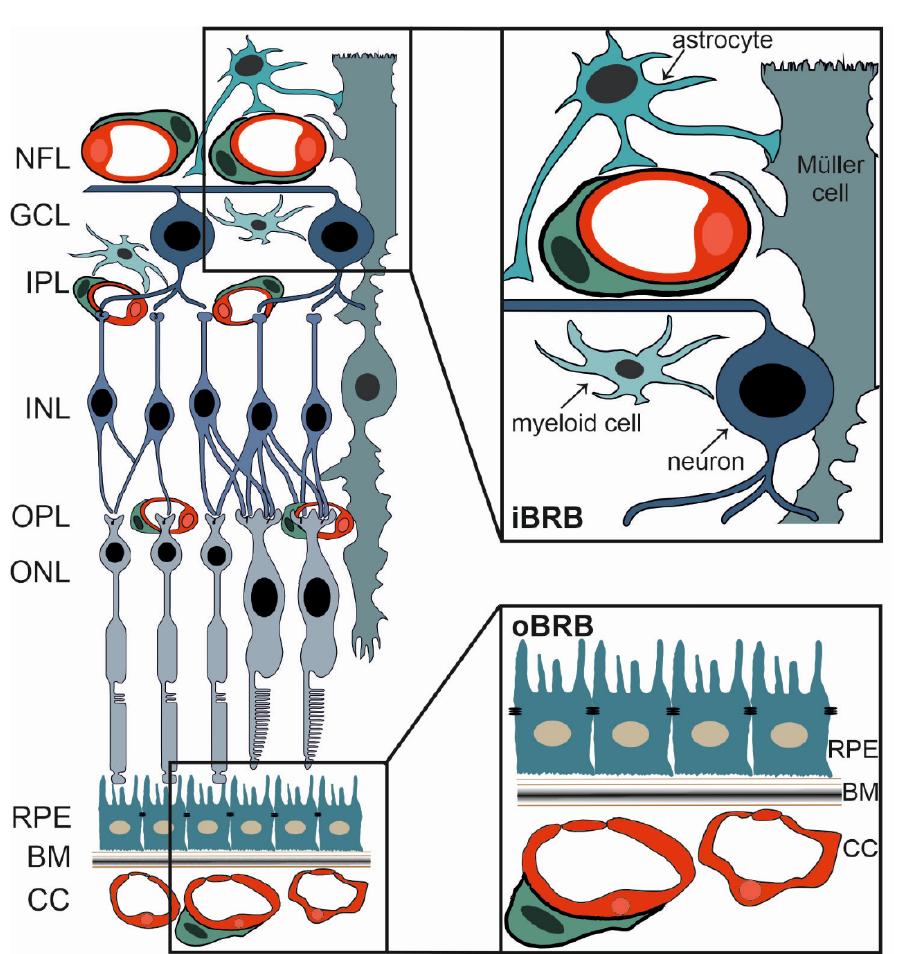
Figure 1. The neurovascular unit and the two blood retinal barriers (BRB). Schematic depicting the morphological architecture of the retina, the Bruch’s membrane (BM) and the choriocapillaris (CC). The inner BRB (iBRB, right upper panel) is formed by tight junctions of endothelial cells (shown in red) of the intraretinal vessels. The neurovascular unit constituting of cells such as pericytes (green), astrocytes, myeloid cells (microglia/macrophages), Müller cells and retinal neurons critically contribute to the integrity of the BRB, too. The outer BRB (oBRB) is formed by the cells of the retinal pigment epithelium (RPE), which are connected by tight junctions. NFL = nerve fiber layer, GCL = ganglion cell layer, IPL = inner plexiform layer, INL = inner nuclear layer, OPL = outer plexiform layer, ONL = outer nuclear layer, RPE = retinal pigment epithelium, BM = Bruch’s membrane, CC = choriocapillaris.